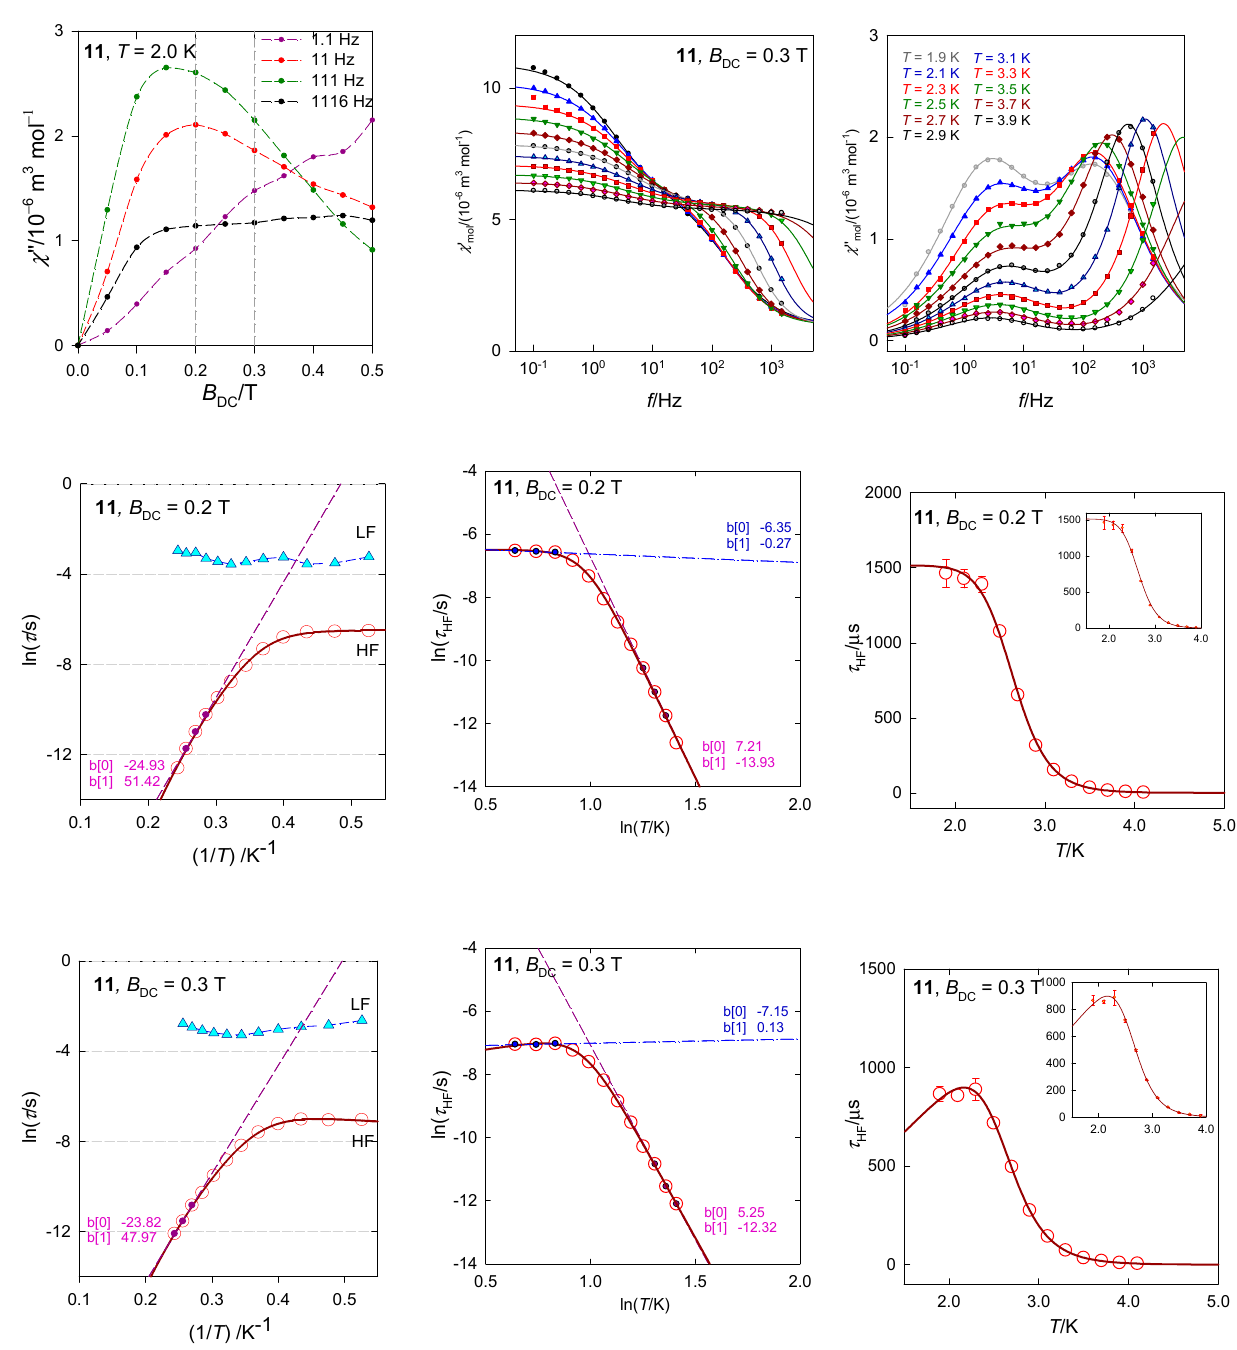
Figure 20. AC susceptibility data for 11 . Full lines—fitted. Data adapted from ref. [33]. 2015, Royal Society of Chemistry.